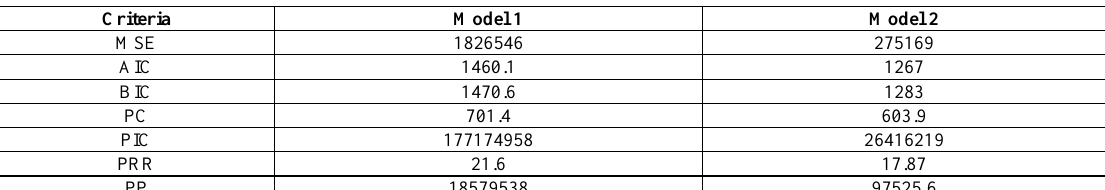
Table 5. Model selection criteria based on available data in the United Kingdom